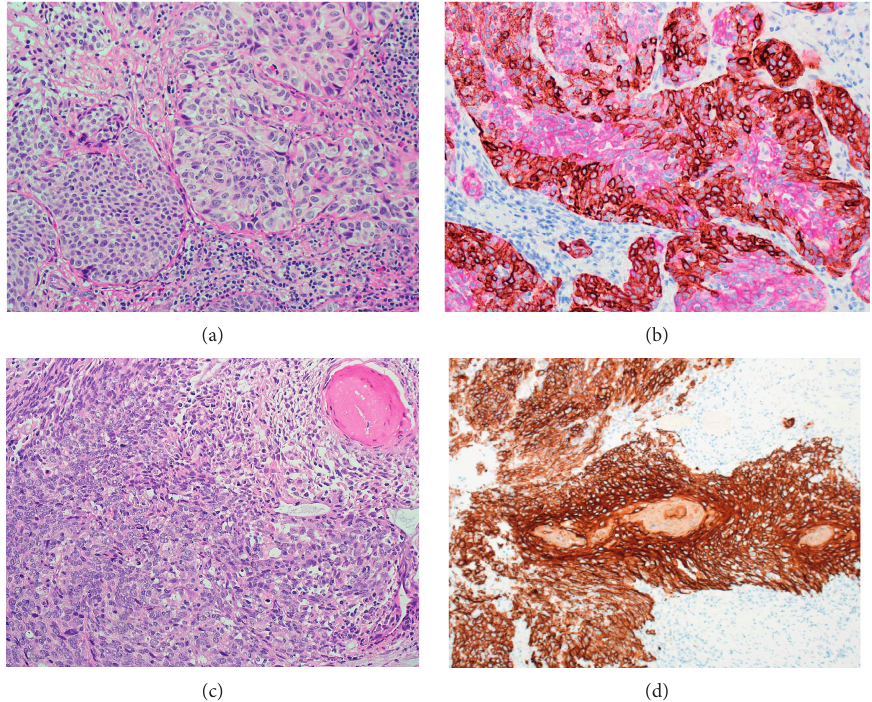
Figure 6: (a) High-grade urothelial carcinoma with focal squamous differentiation. (b) Immunohistochemical staining demonstrating strong CK5/6 staining in the area of squamous differentiation. The remaining part of carcinoma stains for CK20. (c) High-grade urothelial carcinoma with basosquamous morphologic features. (d) Immunohistochemical staining in basosquamous carcinoma featuring strong immunostaining for CK5/6 and complete absence of CK20